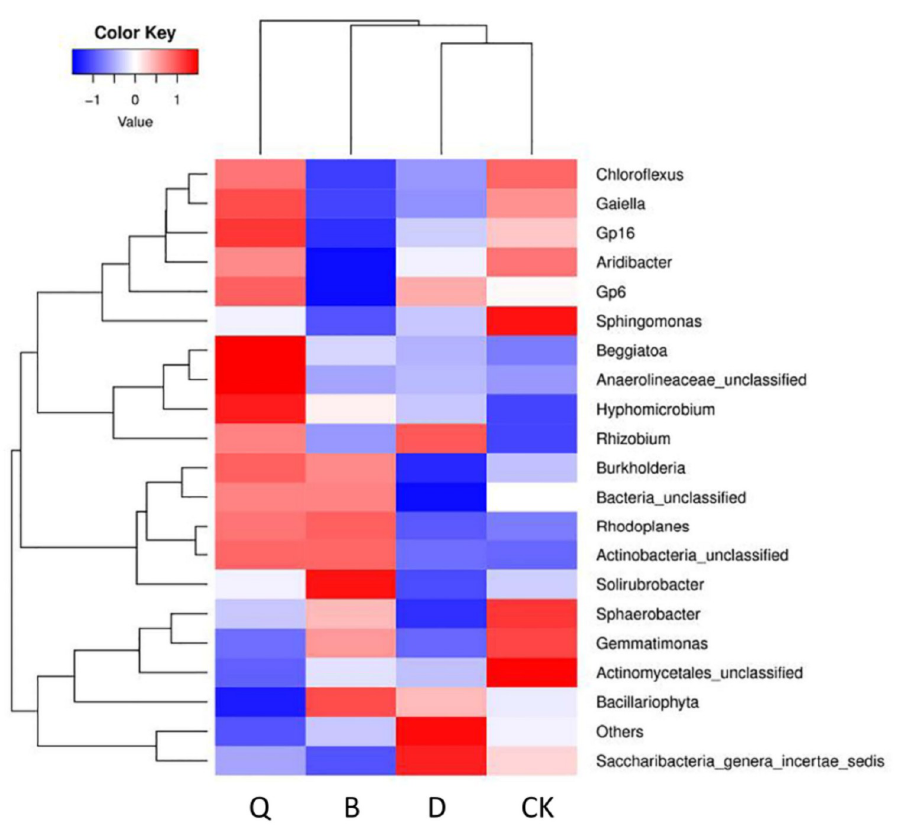
Fig 3. Heatmap of the changes in bacterial community richness in the continuous tomato cropping substrates under different cropping systems. CK: Continuous tomato cropping; Q: Celery/tomato rotation; B: Cabbage/tomato rotation; D: Kidney bean/tomato